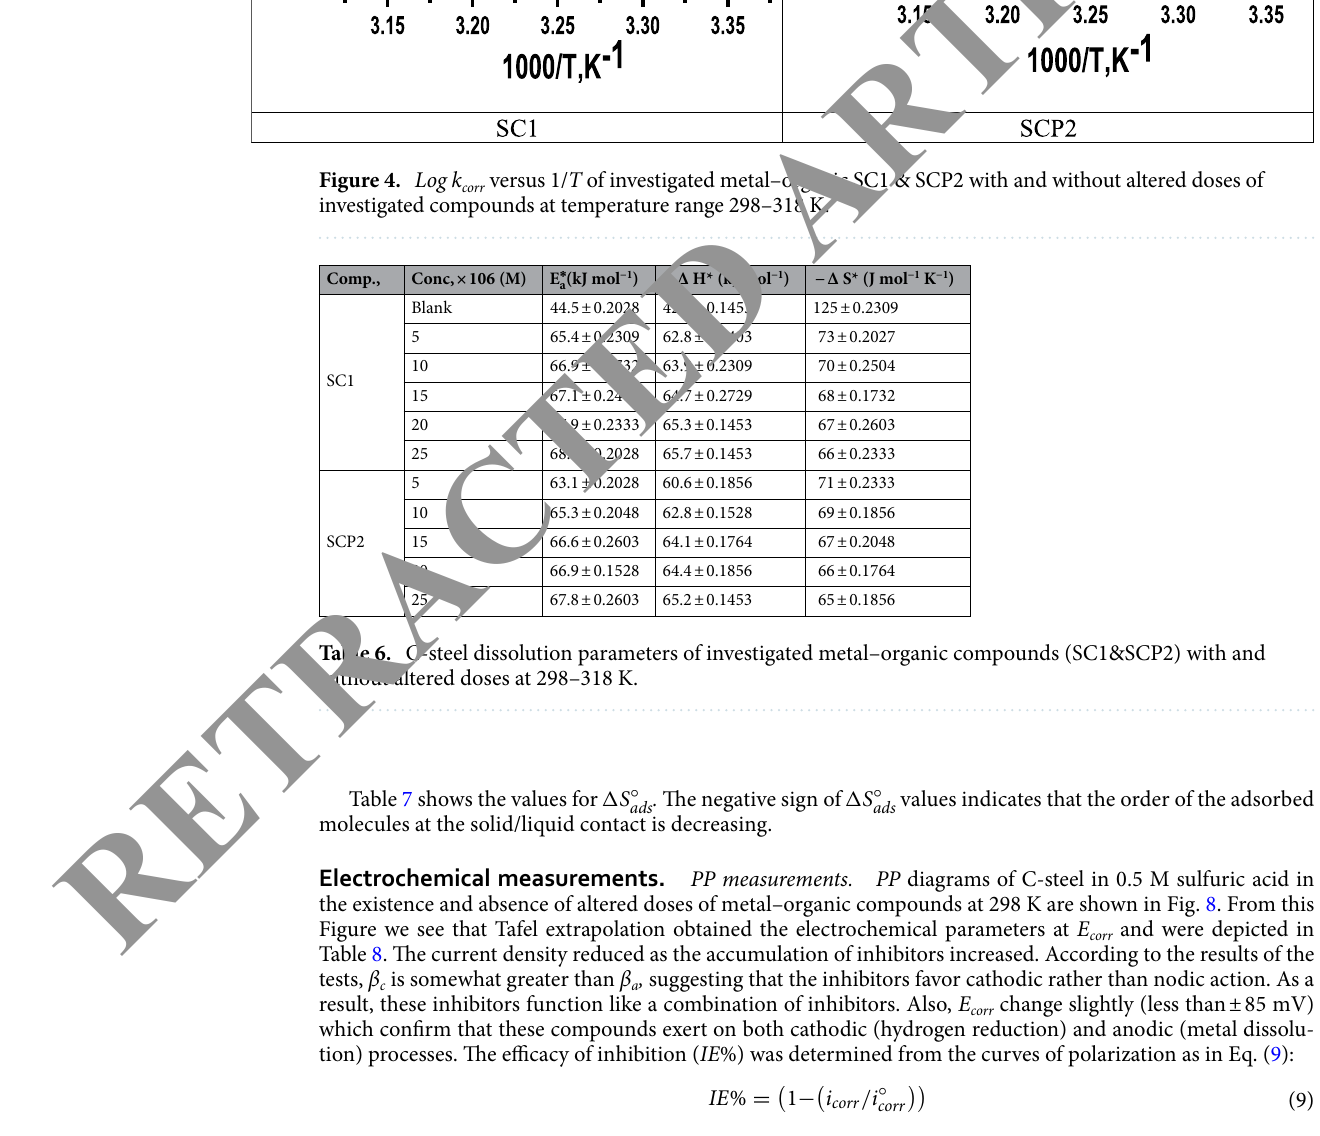
Table 7 shows the values for (cid:31) S ◦ ads . The negative sign of (cid:31) S ◦ ads values indicates that the order of the adsorbed molecules at the solid/liquid contact is decreasing.